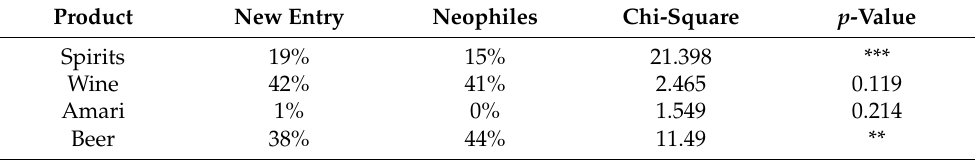
Table 1. Consumption habits of alcoholic beverages for new entries ( n = 253) and neophiles ( n = 118). Table 2. Consumption frequency of alcoholic beverage for new entries ( n = 253) and neophiles Product ( n = 118).